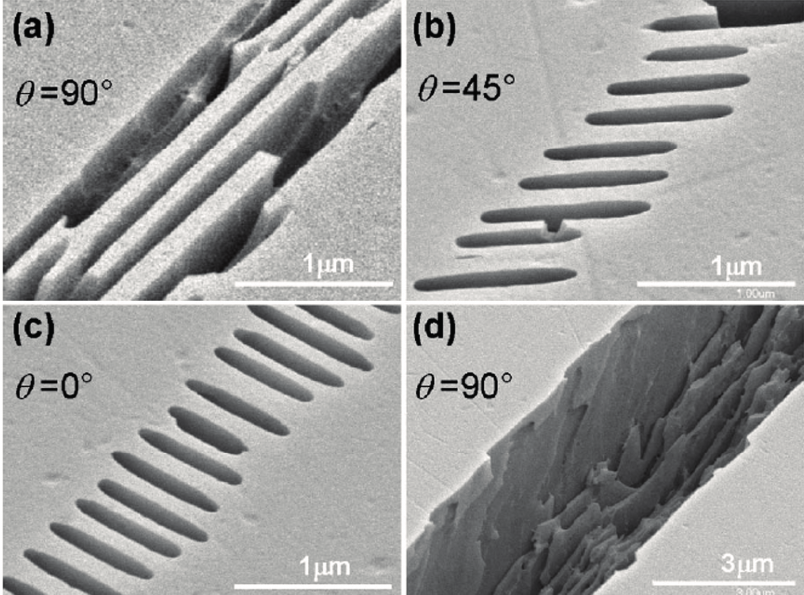
Figure 7. ( a – c ) Top-view SEM images of long-range periodic nanostructures formed along the writing direction for different values of θ (angle between laser-beam polarization direction and writing direction) for a pulse energy E p = 300 nJ; ( d ) E p = 900 nJ. The structures were revealed after 20 min of etching in a 0.5% aqueous solution of HF [83] (Reproduced with permission from OSA. © 2005 by the Optical ciety of